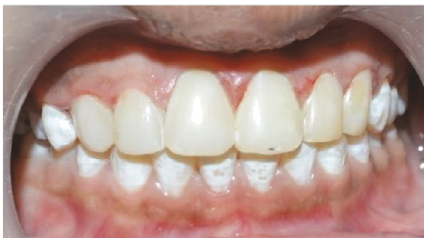
Figure 2: Finished and polished restoration.